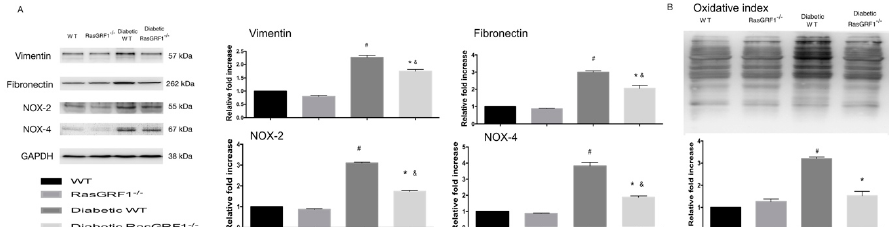
Figure 7. Effects of Rasgrf1 knockout prevented diabetes-induced oxidative stress and extramatrix accumulation ( A ) Chronic diabetes upregulated the proteins of the extracellular matrix markers vimentin and fibronectin, and oxidative stress markers NOX2 and NOX4 in heart tissue. However, the upregulation of these proteins was attenuated in diabetic RasGRF1 − / − mice ( n = 3). The protein levels are expressed as a ratio to β -actin, and normalized to sham control wild-type (WT). ( B ) The oxidative index and protein carbonyls were substantially higher in diabetic WT mice than in the control groups and diabetic RasGRF1 − / − mice ( n = 3). Data are shown as mean ± SEM in three independent experiments. # p < 0.01 vs. normal WT and normal RasGRF1 − / − mice; * p < 0.05 vs. diabetic WT mice. & p < 0.05 vs. normal WT and normal RasGRF1 − / − mice. WT: wild-type.